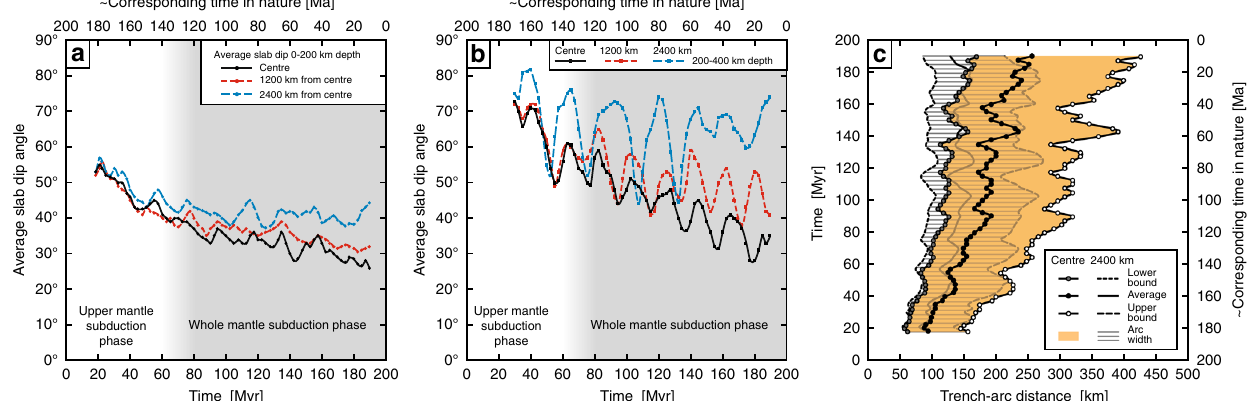
Fig. 9 Numerical results showing the temporal evolution of the slab dip angle and magmatic arc migration. a Average slab dip angle at 0 – 200 km depth in three locations (centre of the wide subduction zone, 1200 km from the centre and 2400 km from the centre). b Average slab dip angle at 200 – 400 km depth in three locations (centre of the wide subduction zone, 1200 km from the centre and 2400 km from the centre). c Evolution of the magmatic arc position and width with respect to the trench in two locations (centre of the wide subduction zone and 2400 km from the centre) (for calculations see